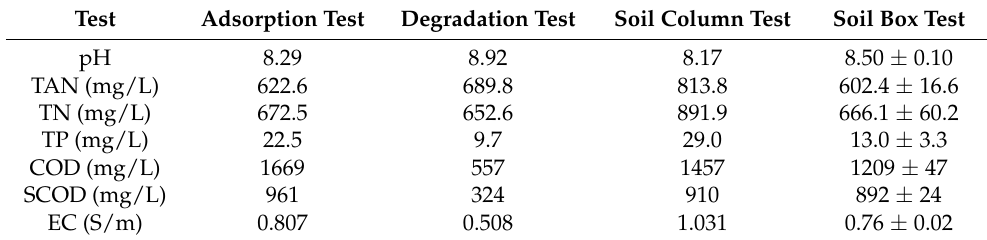
Table 1. Characteristics of feedstock in different